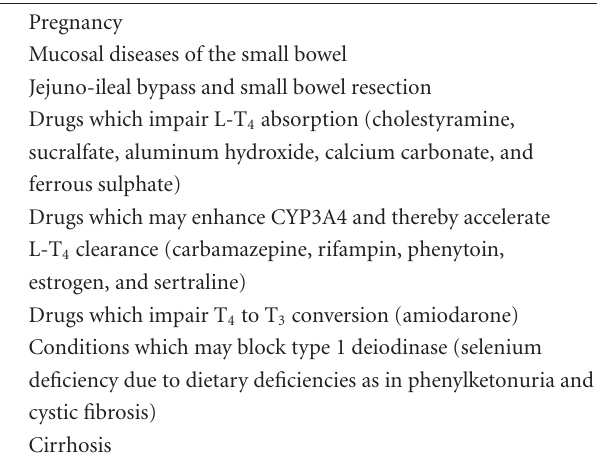
Table 3: Conditions that increase L-T 4